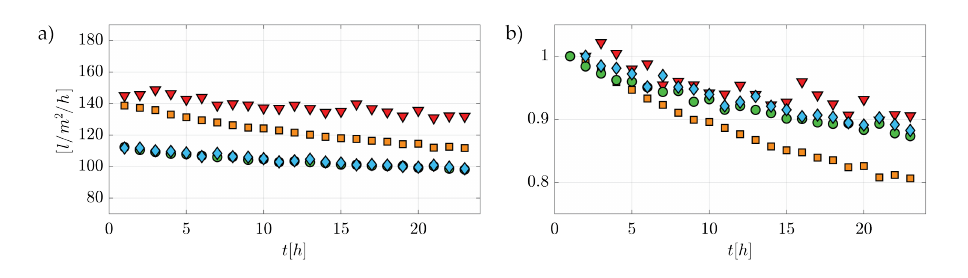
Figure 6. Dimensional (panel ( a )) and non-dimensional (panel ( b )) filtrate fluxes vs. time for all experimental conditions (symbols as indicated in Table 2). In Panel ( b ), filtrate fluxes are normalized by their initial